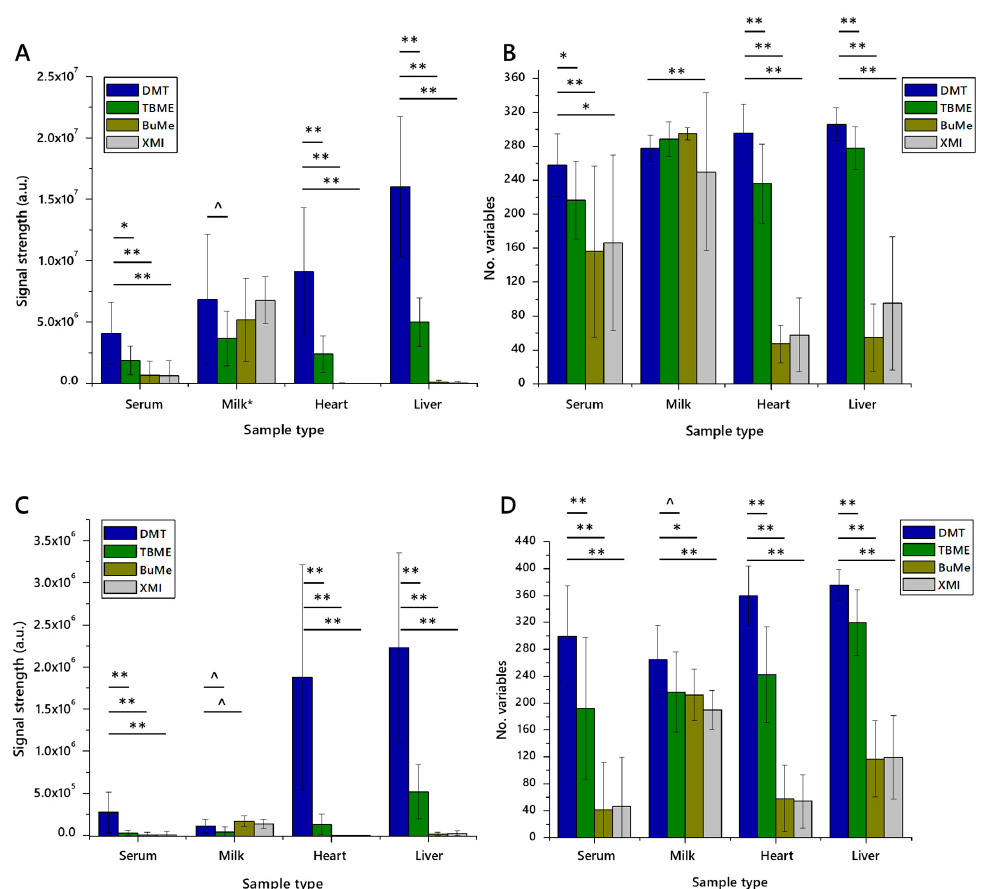
Figure 1. The signal strength and number of lipid variables detected in lipid extracts from four different matrices using four different extraction methods for high-throughput lipidomics ( n = 20 measurements of each). Panel ( A ), total signal strength in positive ionisation mode; ( B ), number of variables identified in positive mode; ( C ), total signal strength in negative ionisation mode; ( D ), number of variables identified in negative mode. Error bars show standard deviation. BuMe, butanol/methanol 1:1; DMT, dichloromethane/methanol/triethylammonium chloride 3:1:0·005; TBME, tert -butylmethylether; XMI, xylene, methanol, isopropanol 1:2:4. Samples: serum, human blood serum; milk; unhomogenised Jersey cows’ milk; heart, murine heart homogenate; liver, mouse liver homogenate. ^ p < 0·05; * p < 0·01; ** p < 0·001. The TBME and DMT methods performed better than the non-aqueous methods, presumably assisted by the aqueous fraction’s ability to dissolve and separate proteinaceous and perhaps carbohydrate material from the organically-soluble fraction. The isolates prepared using the DMT method comprised more variables and gave rise to a higher total signal strength than those prepared using TBME. Whether or not class abundance differed between extraction methods was then tested by assessing the relative abundance of representative lipid classes. A major lipophilic component (triglycerides) and an abundant zwitterionic phospholipid (phosphatidylcholine), as well as a lower abundance lipophilic class, sterols (cholesteryl esters and cholesterol itself) in serum and heart preparations, Figure 2, were used. These classes represent the bulk of the signal strength recorded, and are of interest in metabolic studies and thus are important in deciding which method(s) are most appropriate or efficient for a given study. The relative abundance scores of phosphatidylcholine (PC), triglycerides (TGs), cholesteryl esters (CEs) and cholesterol indicated that the relative abundance of